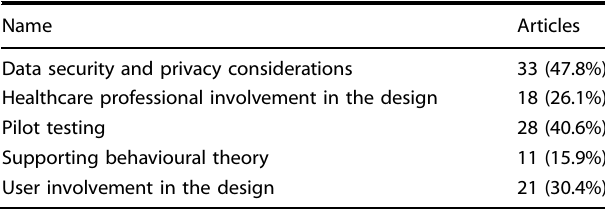
Table 2. Developmental factors considered by the included studies ( n =